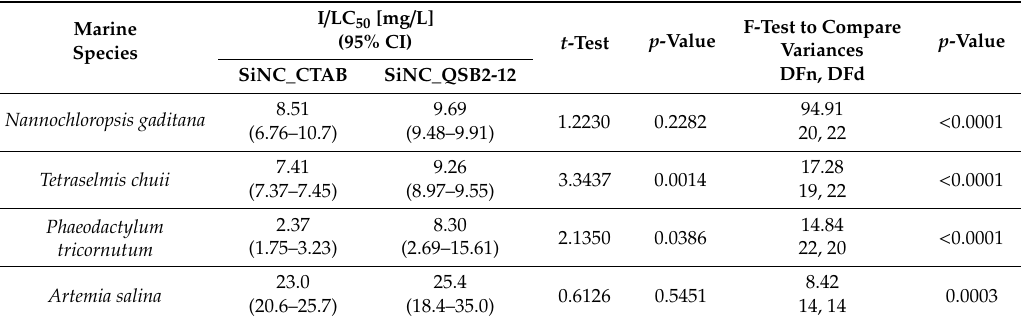
Figure 7. ( a ) Nitrogen adsorption – desorption isotherms and ( b ) pore size distribution of silica nanocapsules. Table 3. Toxicity of synthesized reference (SiNC_CTAB) and newly developed (SiNC_QSB2-12) silica nanocapsules towards marine species and statistical comparison of I / LC 50 through t -tests and F-tests per tested